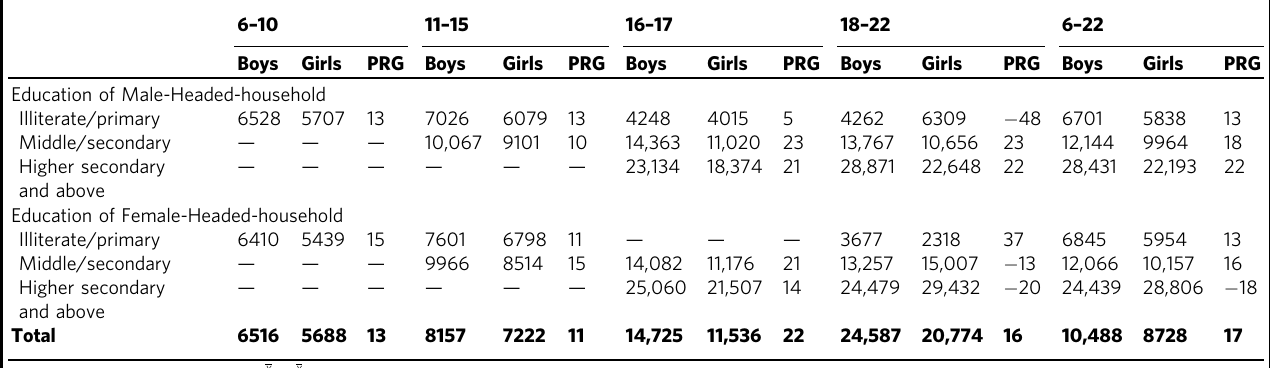
Table 4 Gender gap in per capita educational spending (in Rs.) during the current academic year of basic course by gender and education of household head in 6 – 22 age groups of India, 2017 – 18.